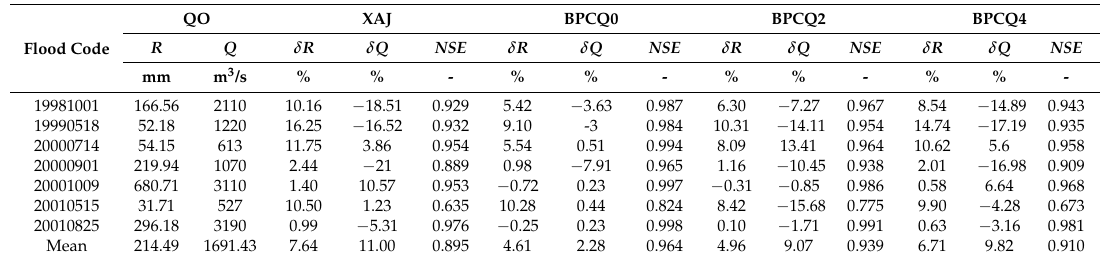
Table 2. Single period correction performance for calibration period.